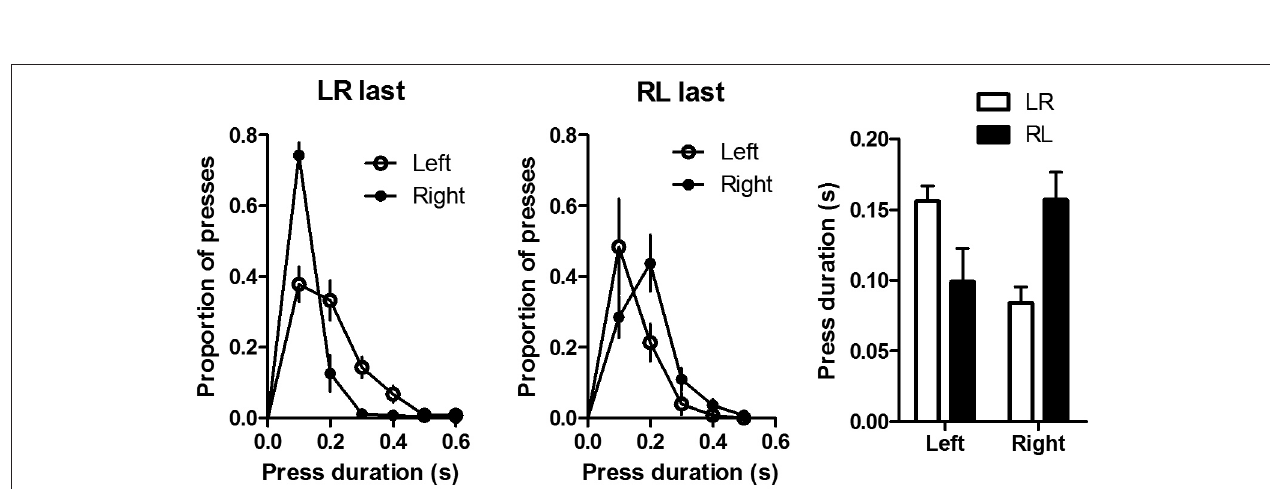
FIgure 9 | Lever press duration distributions of the first and second actions during sequence